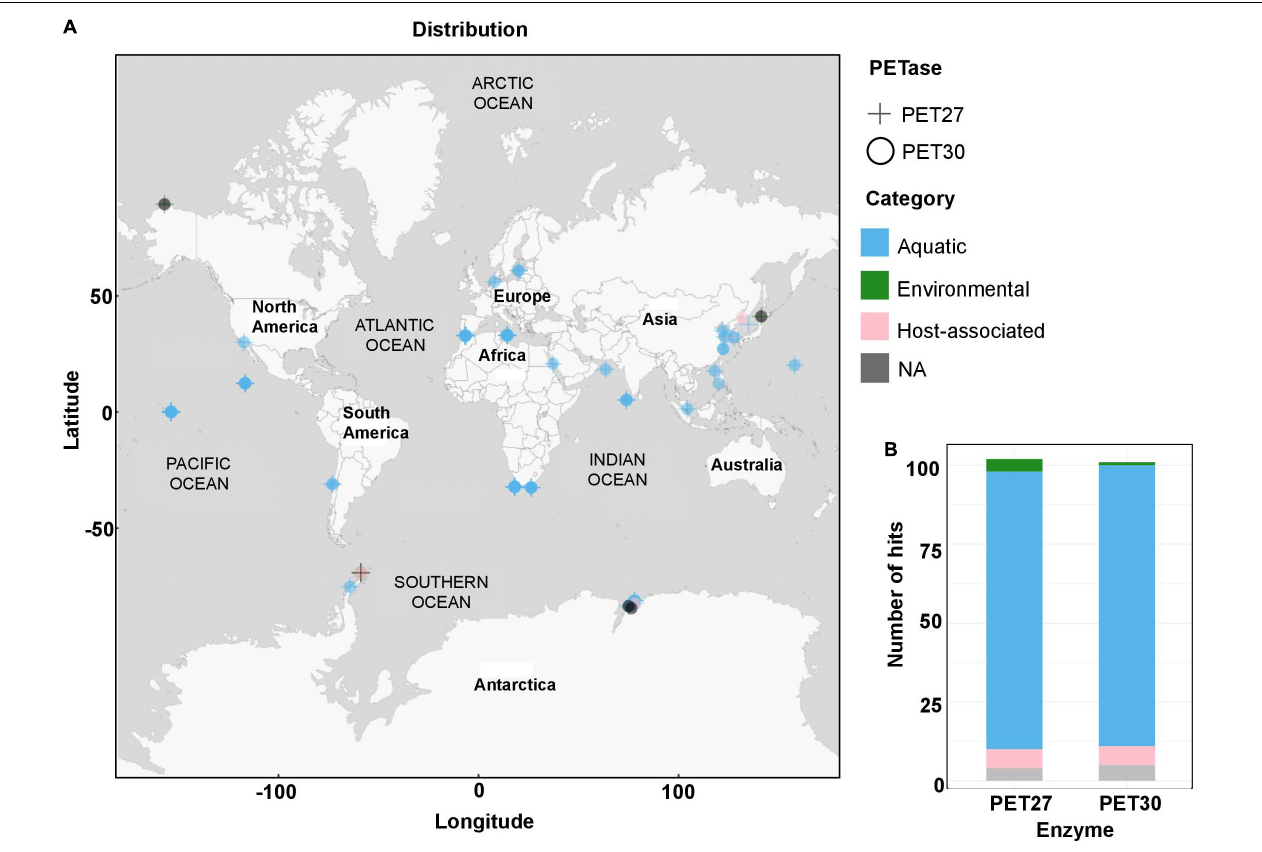
FIGURE 1 | Global distribution of PET27 and PET30 homologs. (A) PET27 and PET30 homologs containing metagenomes were visualized on a world map containing circles for the different metagenomes. The cut-off in the similarity searches was set to 50%. Data depicted include only hits to bacteria affiliated with the Flavobacteria-Cytophaga-Bacteroidetes (FCB) group. The metagenomes searched and included in this figure are listed in Supplementary Table 2 . (B) Number of hits observed in the same global metagenomes. Color code indicates the type of habitat: air, aquatic, terrestrial host-associated and/or engineered.